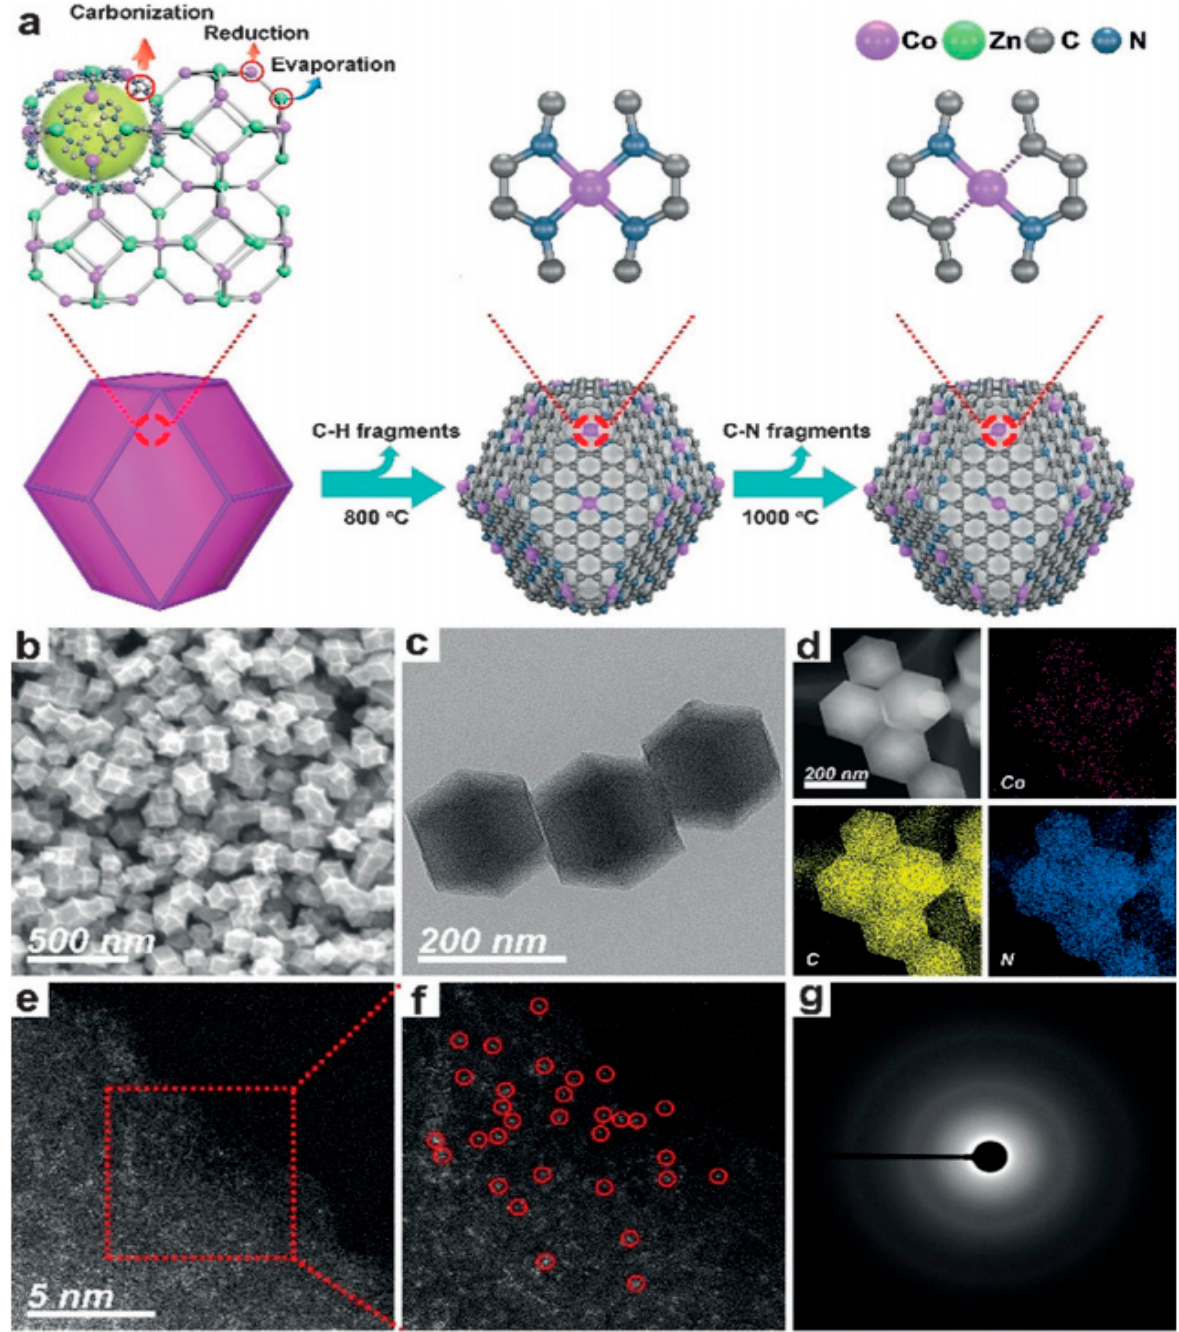
Figure 4. Bimetal Node Doping Strategy. ( a ) The schematic preparation process of Co-N-C by the bimetal node doping strategy; ( b ) scanning electron microscopy (SEM), ( c ) transmission electron microscopy (TEM), ( d ) energy dispersive X-ray spectroscopy (EDX), ( e , f ) high-angle dark field scanning transmission (HAADF-STEM) and ( g ) selected area electron diffraction (SAED) images of Co-N-C sample. Reproduced with permission from Ref. [63], John Wiley & Sons Ltd.: 2018.